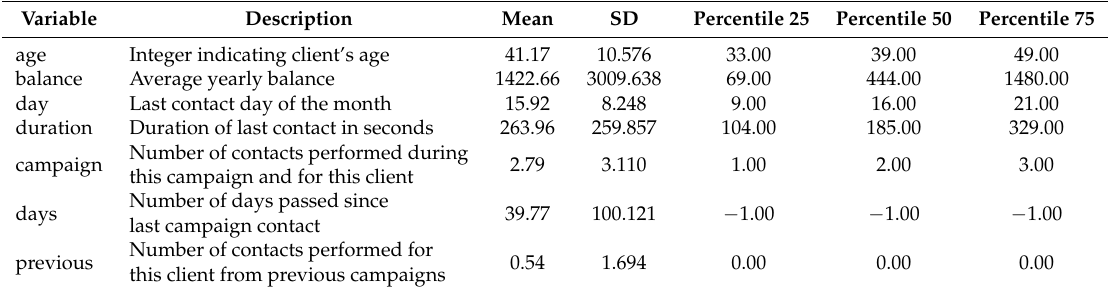
Table 2. Numeric Variables (Portuguese Bank dataset [3]).